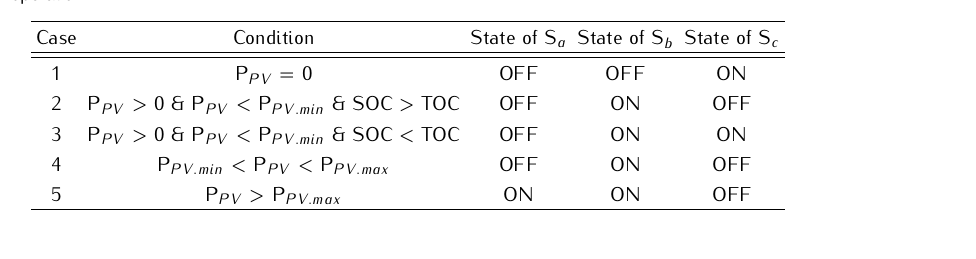
Table 2. Modes of operation